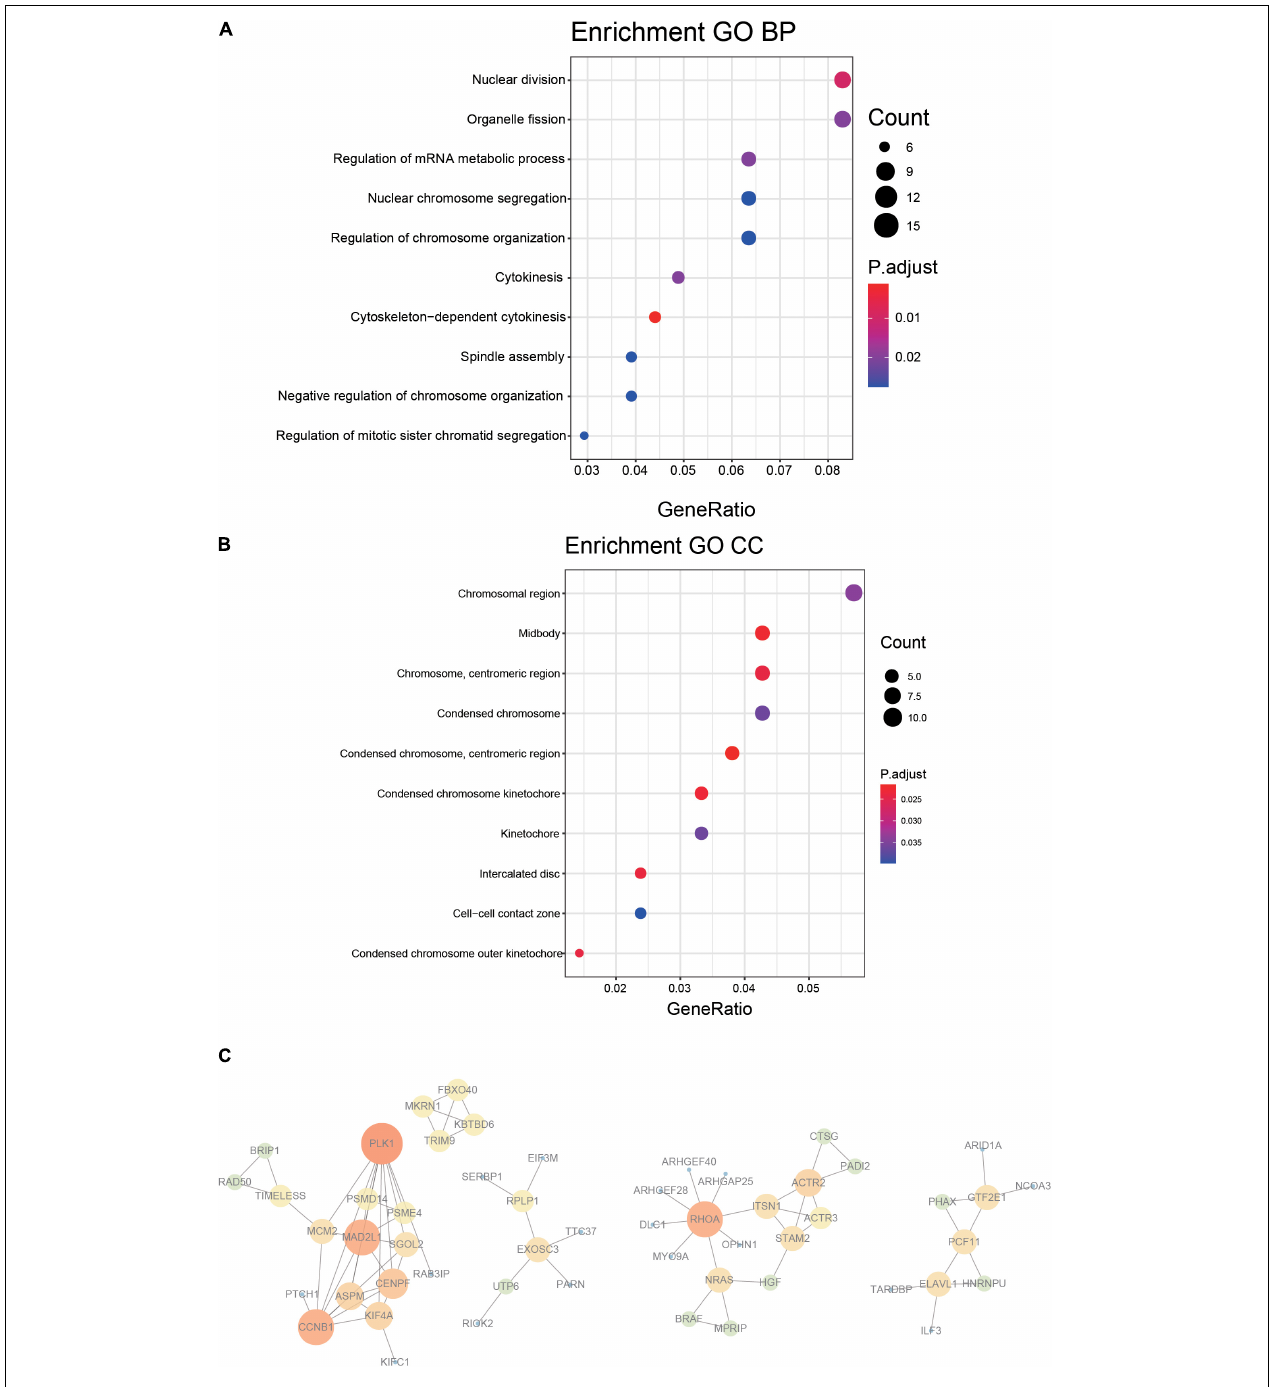
FIGURE 4 | Functional annotation and protein–protein interaction for the genes with significant prognosis. (A,B) Function prediction (BP, biological process; CC, cellular component). (C) Protein–protein interaction.